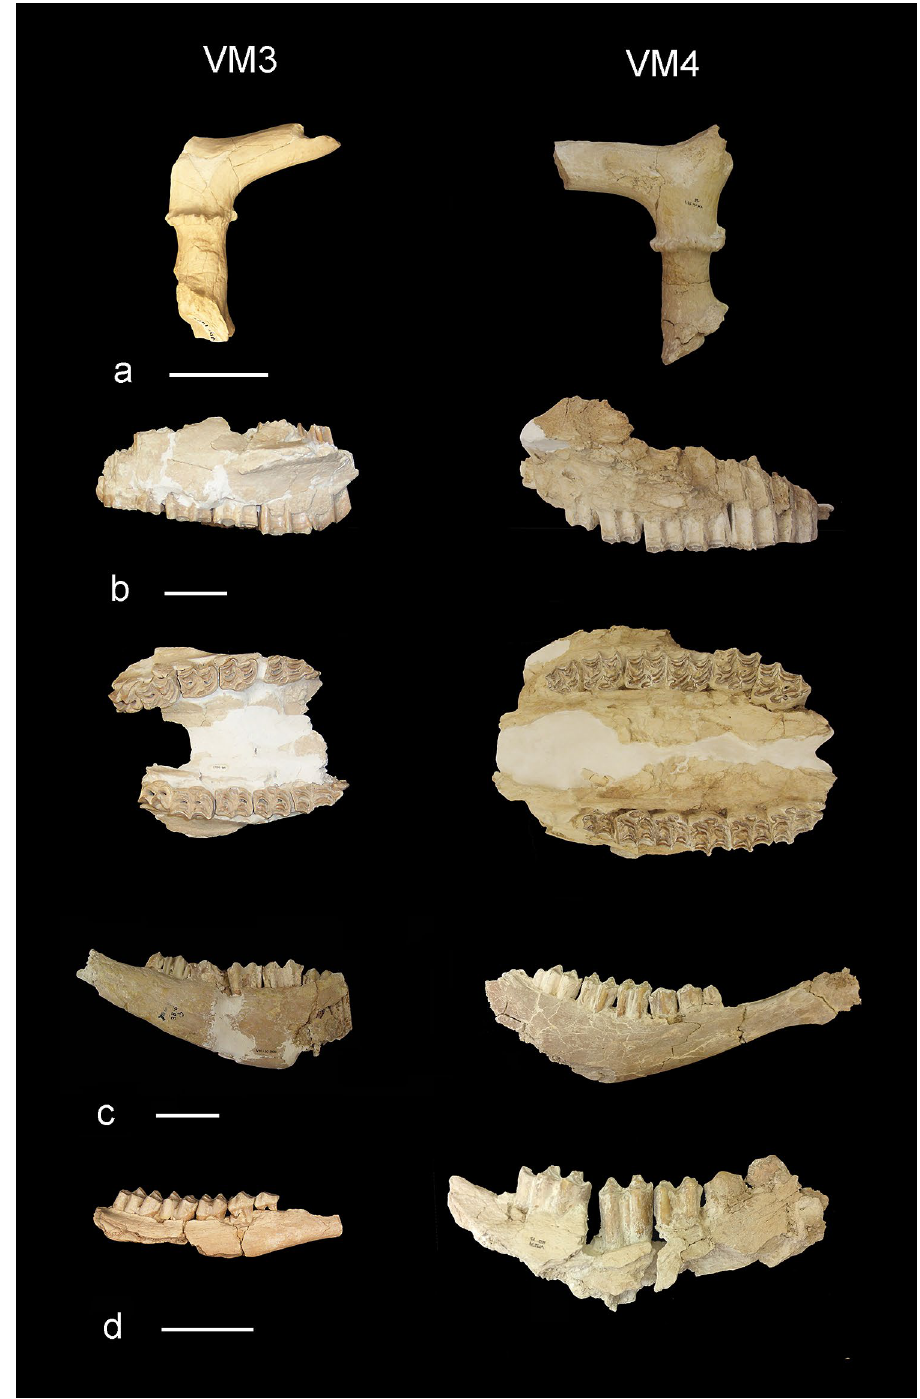
Figure 3. Cranial remains from quarries VM3 (left) and VM4 (right) of Venta Micena showing similar patterns of consumption by the hyaenas 6–10 . ( a ) Antler fragments of Metacervocerus rhenanus. ( b ) Maxillae of Equus altidens in labial (upper photographs) and occlusal views (lower photographs). ( c ) Jaw fragments of Bison sp. ( d ) Jaw fragments of M. rhenanus (left) and Bison sp. (right). Scale bars represent 5